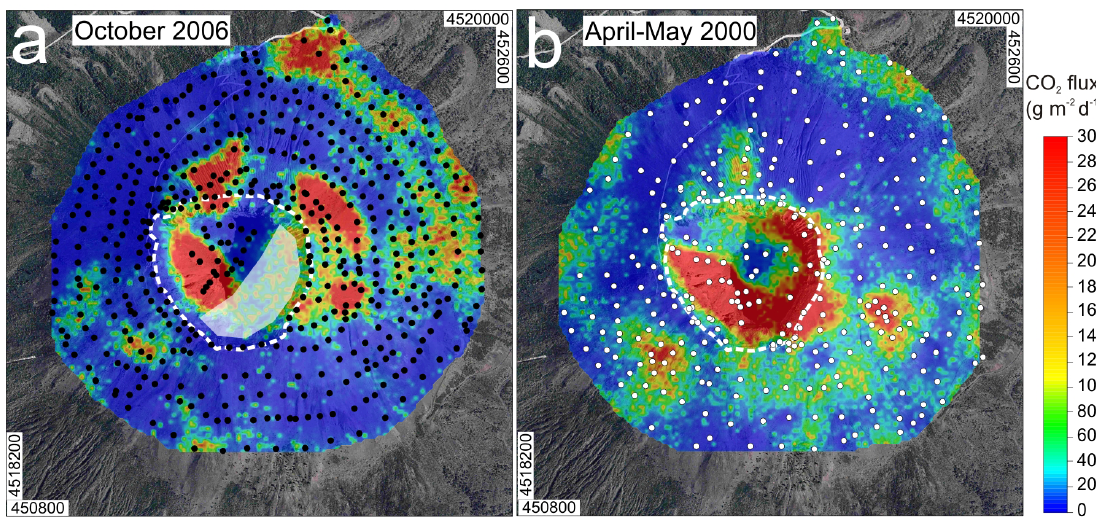
flux maps of a) October 2006 and b) April-May 2000. Maps are the mean of 100 equiprobable representations. Dashed curve Figure 6. CO 2 indicates the rim of the crater while the dots are the measurement point locations. White area in a) highlights the sector of the crater not covered by measurements during the October 2006 survey.